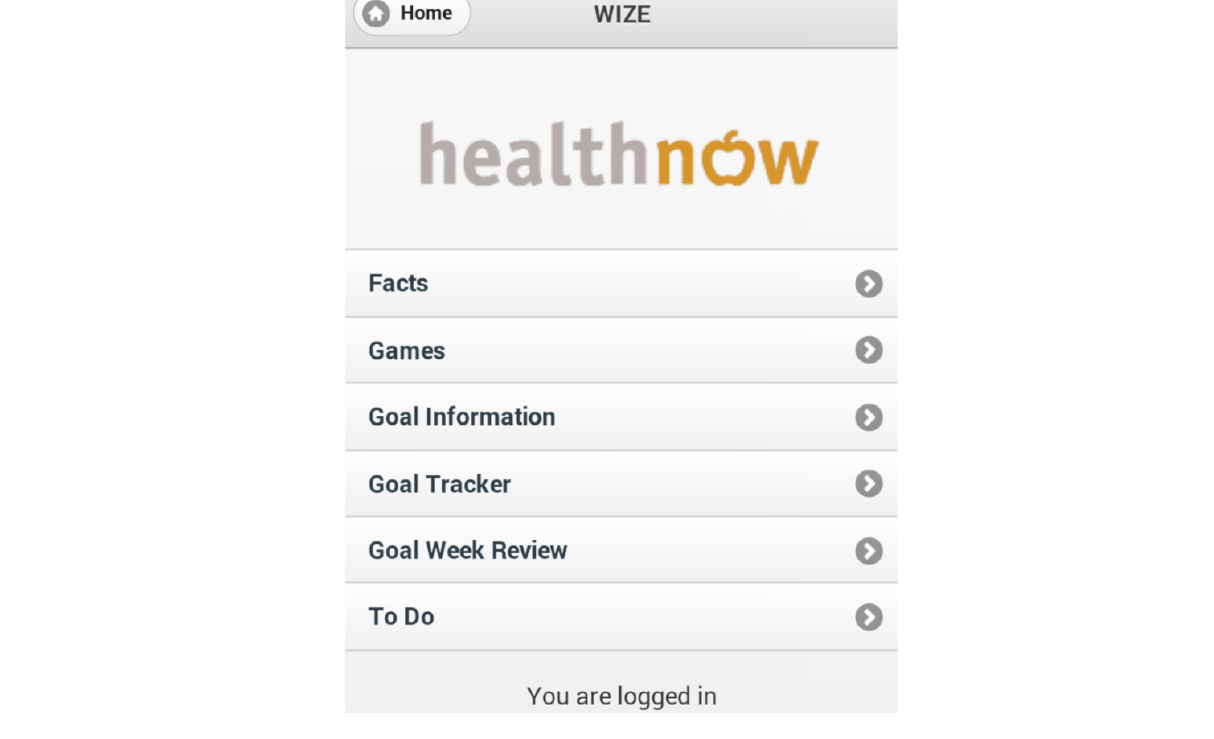
Figure 2. Screenshot of app providing an example of a fact about